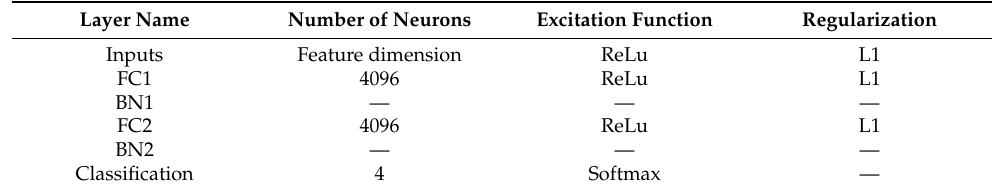
Table 3. Core parameters of each layer of the Analysis of Variance-F value-Spectral Embedding Net (AF-SENet